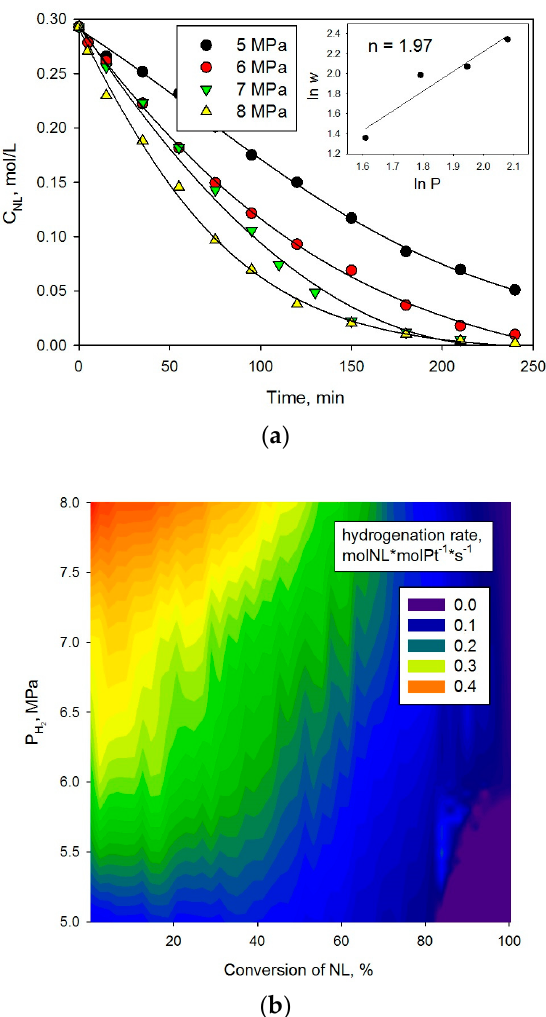
Figure 4. Dependence of NL consumption on time at variation of the overall pressure ( a ) and diagram of specific instantaneous reaction rate as a function of both NL conversion and pressure ( b ) (1.5 g of NL, 0.1 g of catalyst, 40 mL of hexane, 250 °C).